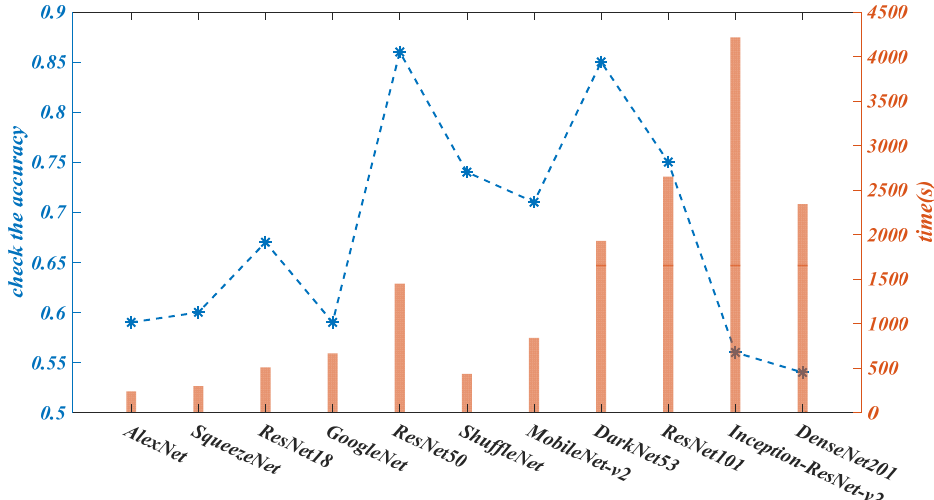
Figure 10. Comparison diagram of preliminary test of small amount of data on network perfor- mance.